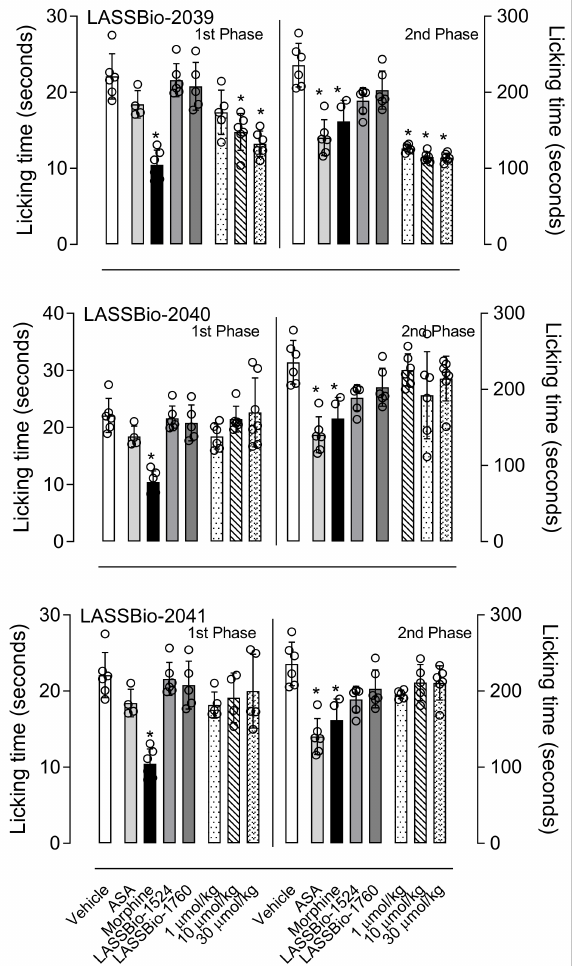
Figure 4. LASSBio-2039, LASSBio-2040 and LASSBio-2041 effects in an inflammatory pain model. Mice were orally treated with each of the substances with three different doses, acetylsalicylic acid (1100 µ mol/kg), morphine (15 µ mol/kg), LASSBio-1524 or LASSBio-1760 (30 µ mol/kg) or vehicle. One hour later the nociceptive response was induced by intraplantar injection of formalin (2.5%) in right hind paw. Results are expressed as mean ± standard deviation ( n = 5–7). Statistical analyses were calculated in GraphPad Prism 8.0 (San Diego, CA, USA) using analyses of variance (ANOVA) followed by Tukey post-test with p < 0.01 (*) when comparing treated groups with vehicle-treated group. Data for the original compounds (LASSBio-1524 and LASSBio-1760) are original, independent duplicates of past results and have not been published